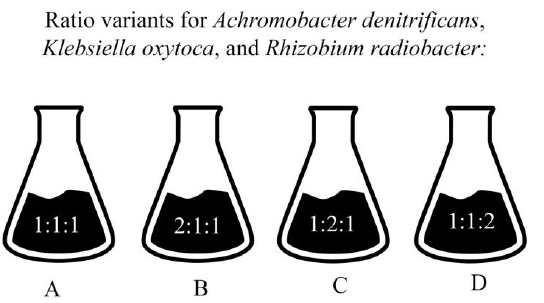
Figure 3. Consortium variants, where ( A – D ) is the name of the consortium with the corresponding concentration of microorganisms Pantoea sp. Achromobacter denitrificans , Klebsiella oxytoca , and Rhi- zobium